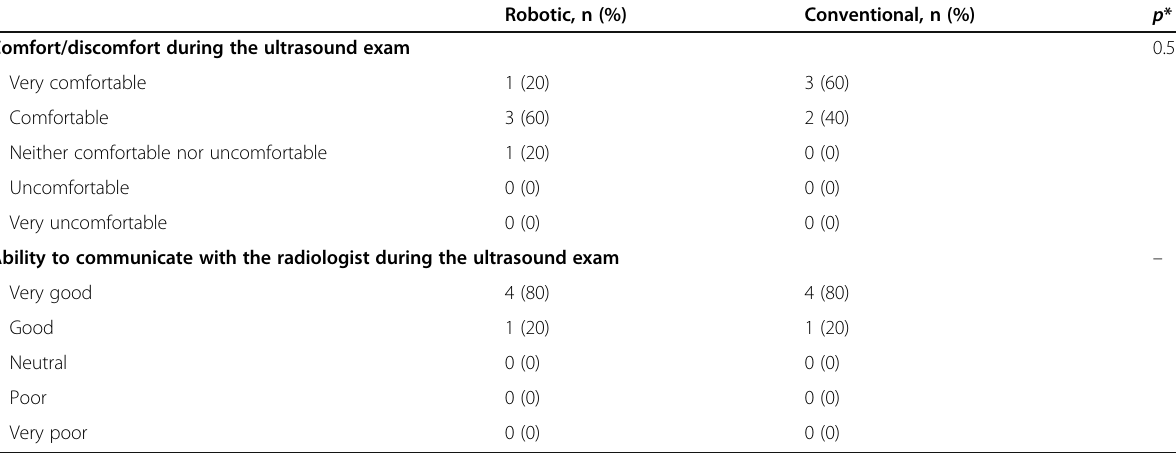
Table 2 Participant assessment of robotic and conventional ultrasound exams Robotic, n (%) Conventional, n (%) Comfort/discomfort during the ultrasound